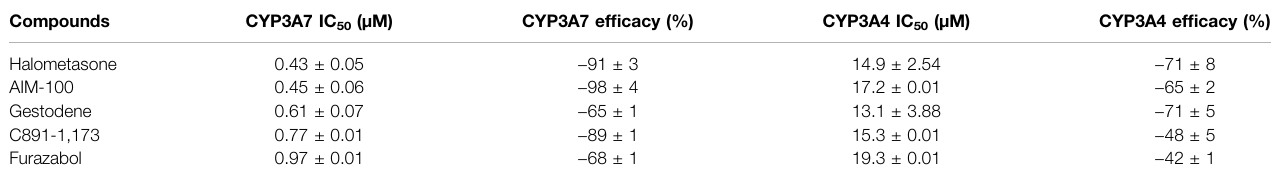
TABLE 2 | The activity and maximum response of inhibitors were compared between CYP3A4 and CYP3A7. Data shown as mean ± SD. Compounds